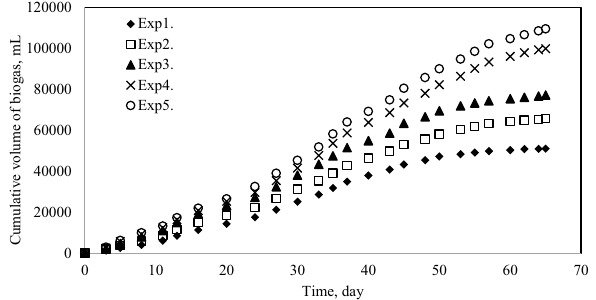
Figure 2. Cumulative biogas